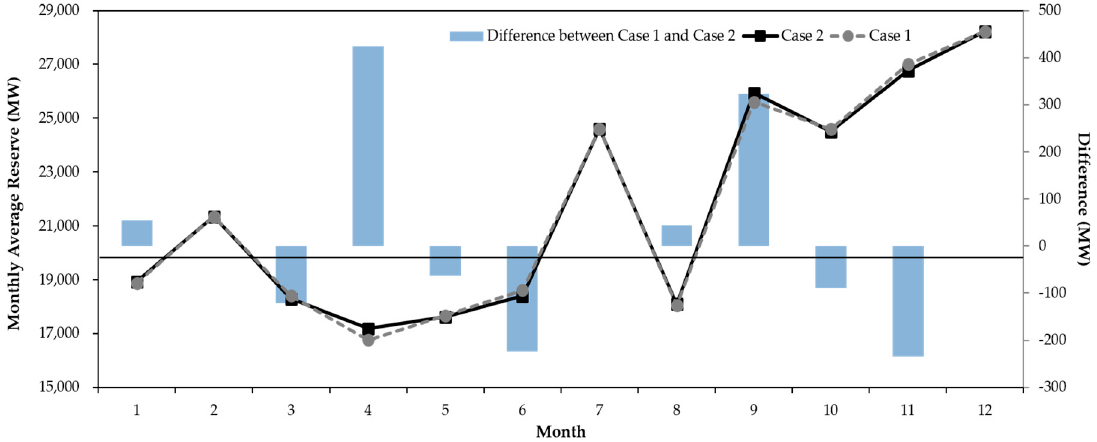
Figure 3. Monthly average supply reserve results for Case 1 and Case 2.